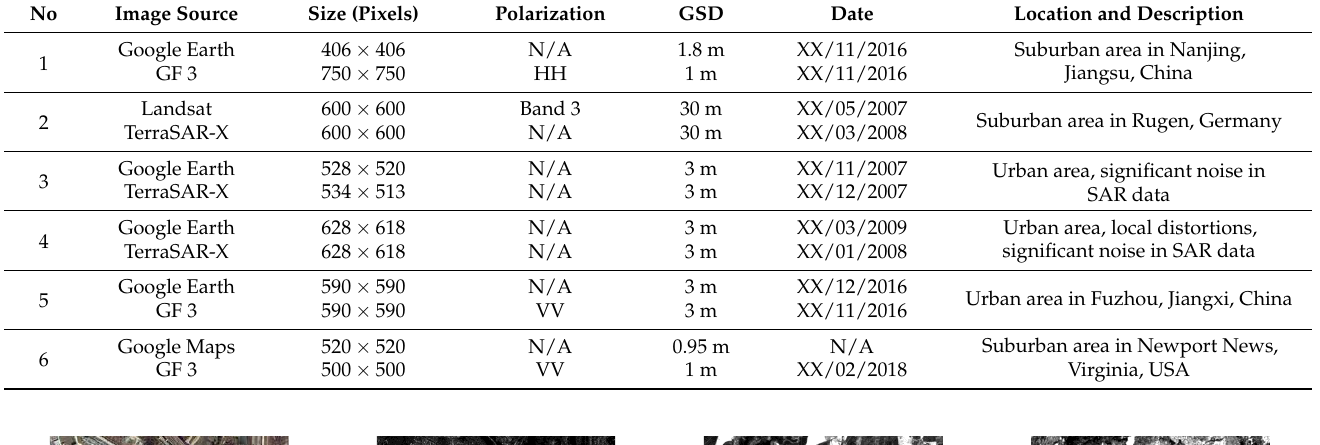
Table 1. Details of the experimental data.